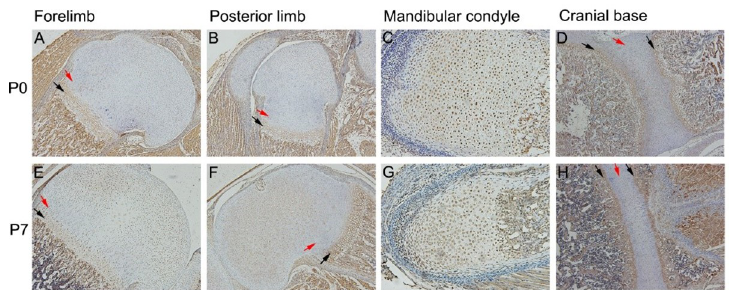
Fig 1. Immunolocalization of FGF9 in mouse limbs epiphyseal cartilage, mandibular condylar cartilage and cranial base synchondrosis. In P0 and P7 limbs epiphyseal cartilage and cranial base synchondrosis, positive staining of FGF9 in the hypertrophic chondrocytes and prehypertrophic chondrocytes (black arrow) was significantly higher than resting chondrocytes or columnar chondrocytes (red arrow) (A/B/D and E/F/H). No similar differences were found in mandibular condyle cartilage at P0 and P7